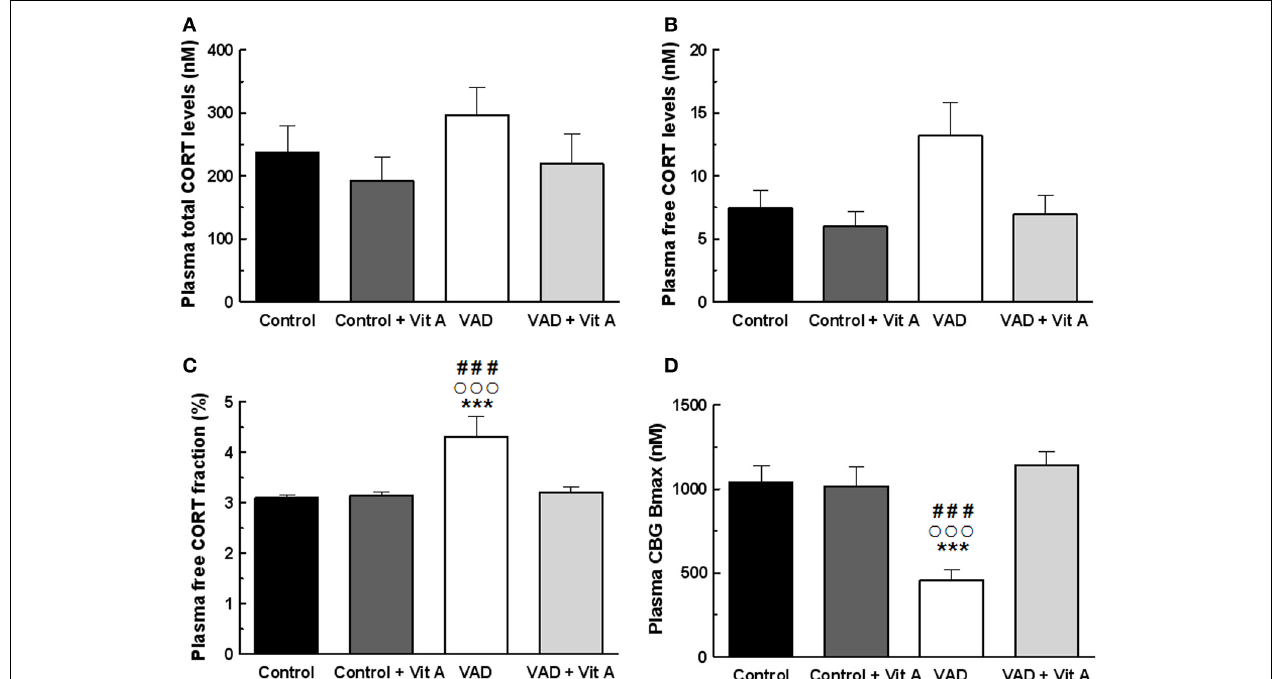
FIGURE 5 | Effects of 14 weeks of VAD and vitamin A supplementation on plasma glucocorticoid status. (A) Total (B) free plasma CORT levels and (C) free plasma CORT fraction measured by RIA. While no significant effect on total CORT levels is detected between all groups, VAD increases free CORT fraction and vitamin A supplementation restores these levels. (D) CBG